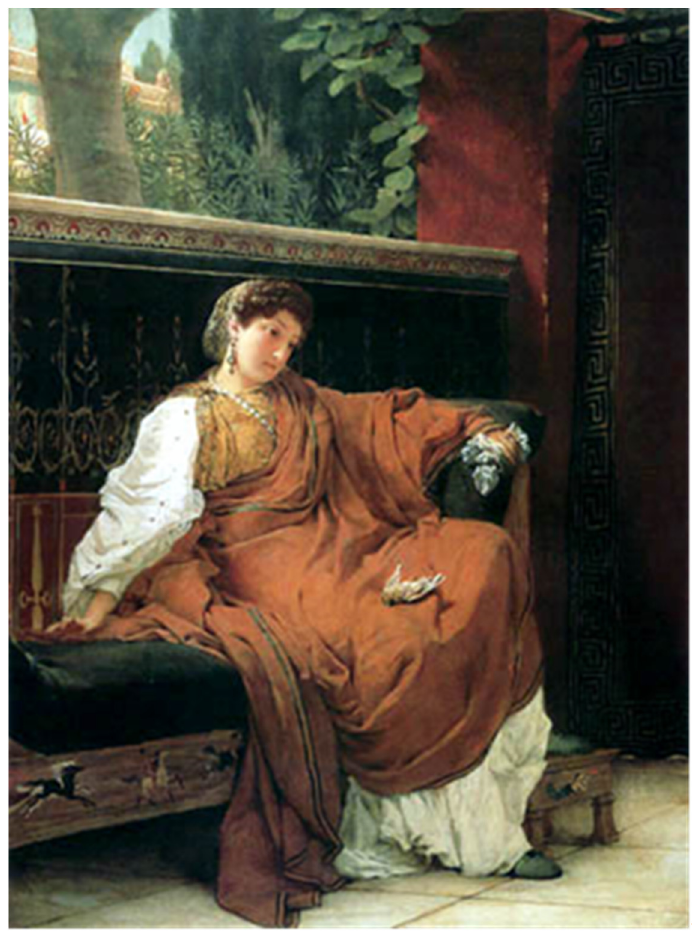
Figure 9. Lawrence Alma-Tadema. “Lesbia, Mourning a Dead Sparrow" (1866).